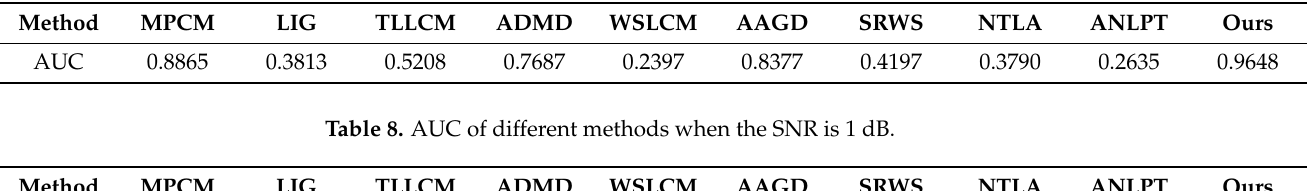
Figure 14. ROC curves of different methods of simulation data. ( a ) is the result of a SNR of 1.5 dB. ( b ) is the result of a SNR of 1 dB. ( c ) is the result of a SNR of 0.5 dB. Table 7. AUC of different methods when the SNR is 1.5 dB.